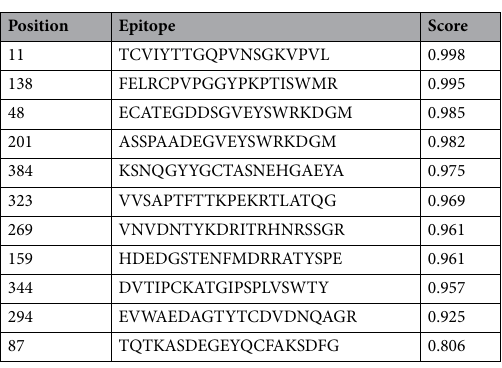
Table 2. B- cell epitope prediction by BCPREDS